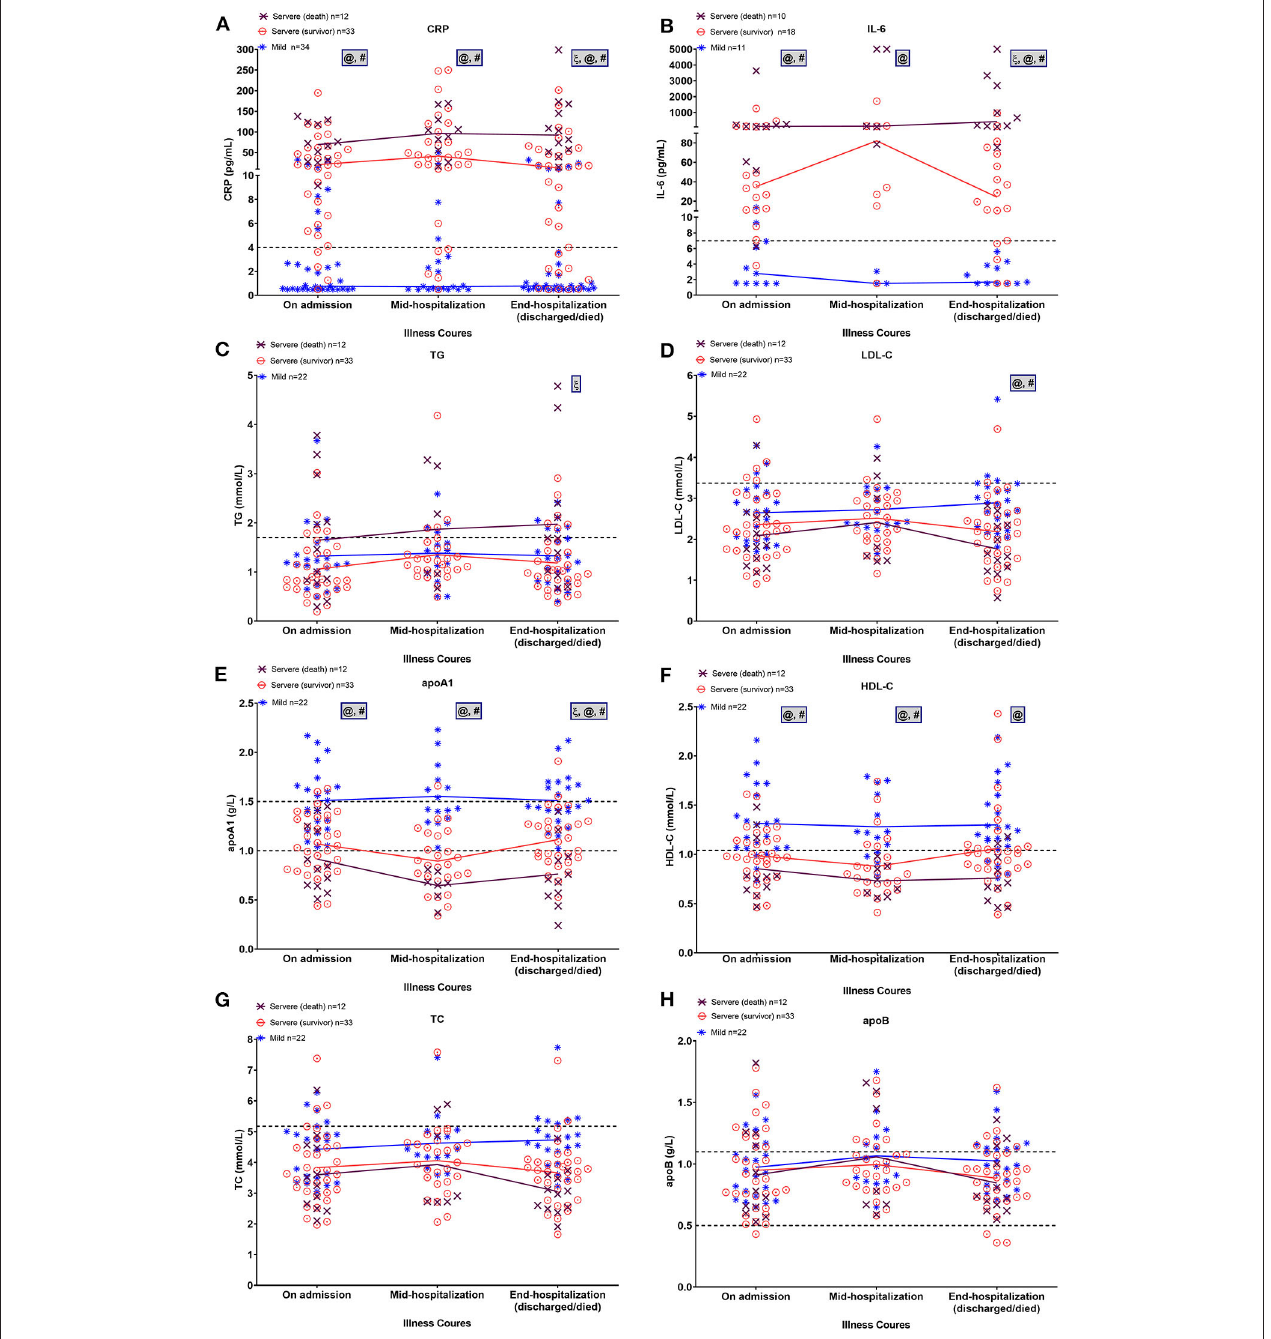
FIGURE 4 | Dynamic alterations in lipid and major laboratory markers from admission in COVID-19 patients. Temporal changes in CRP (A) , IL-6 (B) , TG (C) , LDL-C (D) , apoA-1 (E) , HDL-C (F) , TC (G) , and apoB (H) in a subset of COVID-19 patients with ≥ 2 longitudinal data across three time periods, including on admission, mid-hospitalization, and end of hospitalization. Horizontal dashed lines indicate normal reference range of factors. Mean values of normally distributed parameters (lipid metrics) and median values of non-normally distributed factors (CRP and IL-6) in each group at three time periods are linked by lines. Significant differences among three groups at each time point were compared using one-way ANOVA with Tukey’s multiple comparisons test or Kruskal-Wallis test as appropriate. Statistical significance ( p < 0.05) is indicated by ξ between severe (death) and severe (survivor) cases, @ between severe (death) and mild cases, and # between severe (survivor) and mild cases. IL-6, interleukin-6; CRP, C-reactive protein; TG, triglycerides; TC, total cholesterol; LDL-C, low-density lipoprotein-cholesterol; HDL-C, high-density lipoprotein-cholesterol, apoA-1, apolipoprotein A-1; apoB, apolipoprotein B.